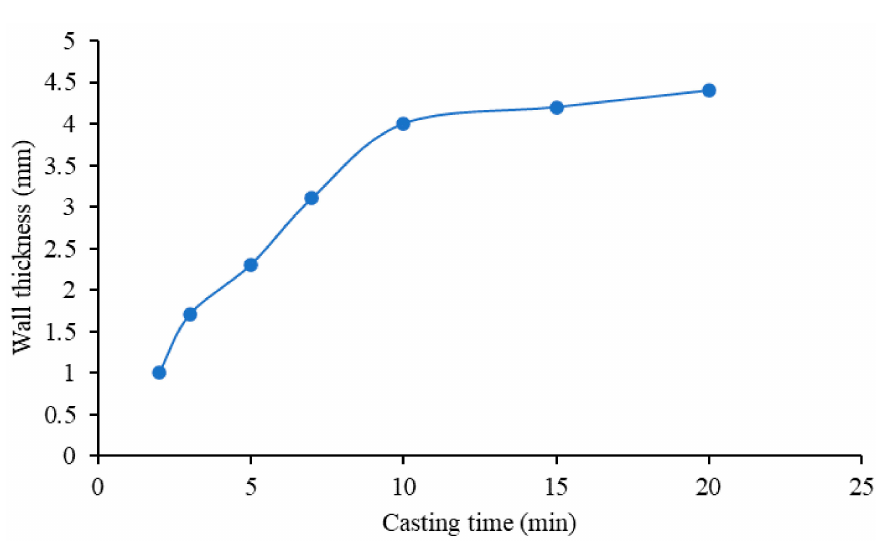
Figure 5. Wall thickness as a function of the casting time for the cups’